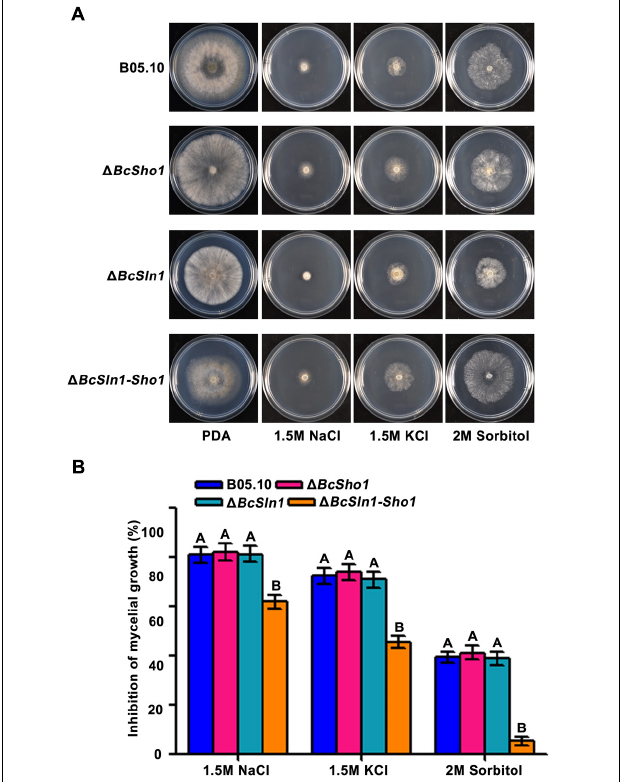
FIGURE 6 | Sensitivity of B05.10, (cid:49) BcSho1 , (cid:49) BcSln1, and (cid:49) BcSln1-Sho1 to osmotic stress. (A) All strains were grown on PDA plates amended with NaCl, KCl, or D-sorbitol at the indicated concentrations at 25 ◦ C for 4 days. (B) Statistical analysis of the growth inhibition rate of all strains under osmotic stress. Bars represent standard errors from three replications. Values on the bars followed by the same letter are not significantly different at P = 0.05.